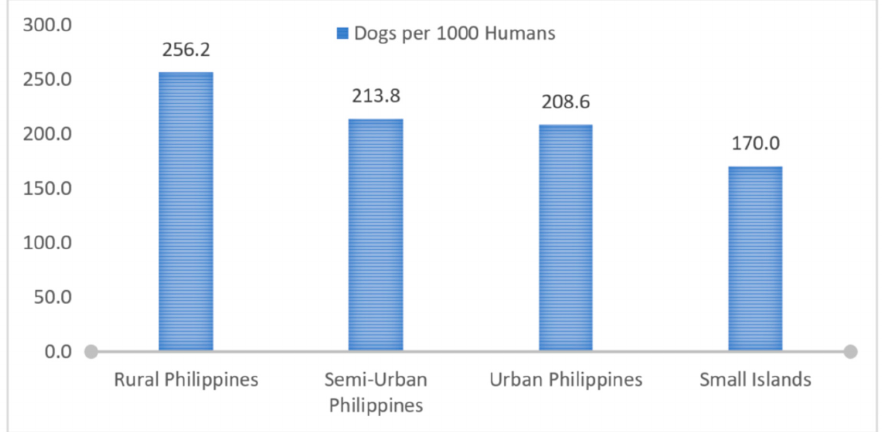
Figure 6. Dogs per 1000 humans based on the level of the urbanisation of the human settlement. Locations combined by the settlement type provide a range of dog densities per 1000 humans (Figure 6). We found 256.2 dogs ( n = 1386, CI 95%, 249.6–262.4) per 1000 hu- mans in rural areas, 213.8 dogs ( n = 2354, CI 95%, 208.7–219.4) per 1000 humans in semi- urban areas, 208.6 dogs ( n = 6224, CI 95%, 203.8–214.2) per 1000 humans in urban areas and 170 dogs ( n = 700, CI 95%, 163.7–176.3) per 1000 humans in small islands of the